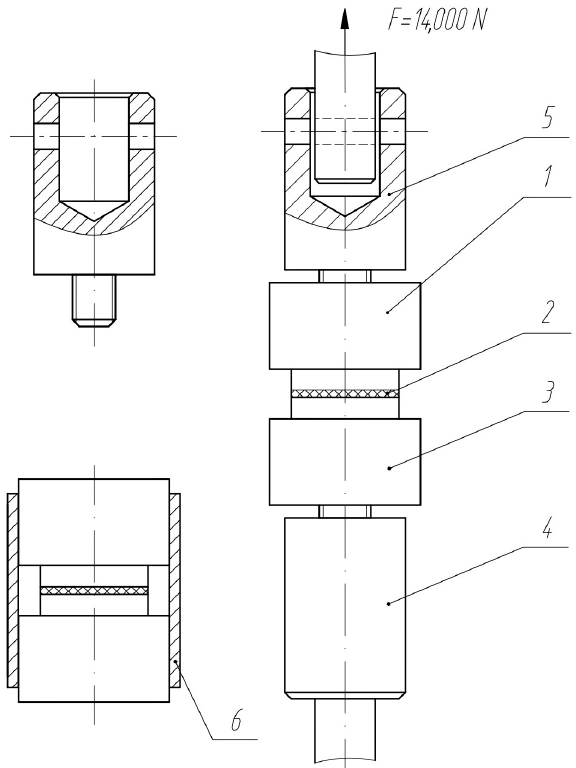
Figure 3. The geometry of a cylindrical specimen (type 2) assembled by tensile force F = 14,000 N: ( 1 ) Specimen with coating; ( 2 ) Epoxy; ( 3 ) Specimen without coating; ( 4 , 5 ) Equipment for tensile testing machine; ( 6 ) Bushing.